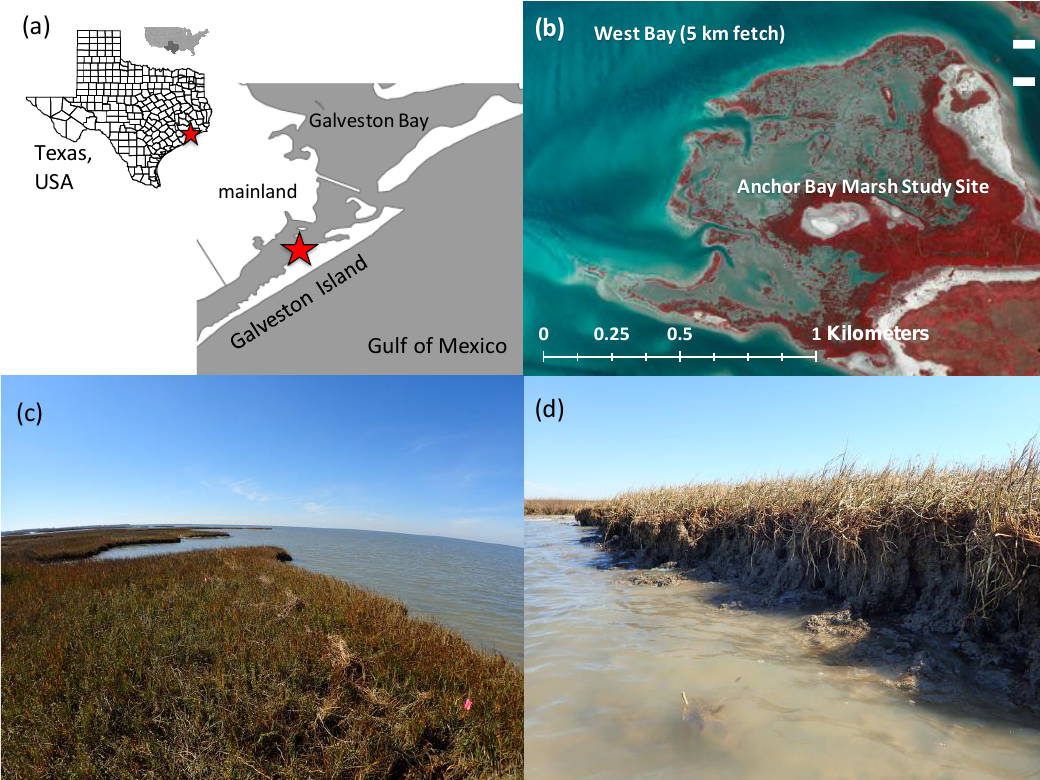
Figure 1. a ) Location of the marsh area study site in relation to its location on Galveston Island, Texas. b ) False color composite aerial imagery of the marsh study site in Anchor Bay. c ) and d ) Photos of the marsh study site taken on 26 February, 2015.